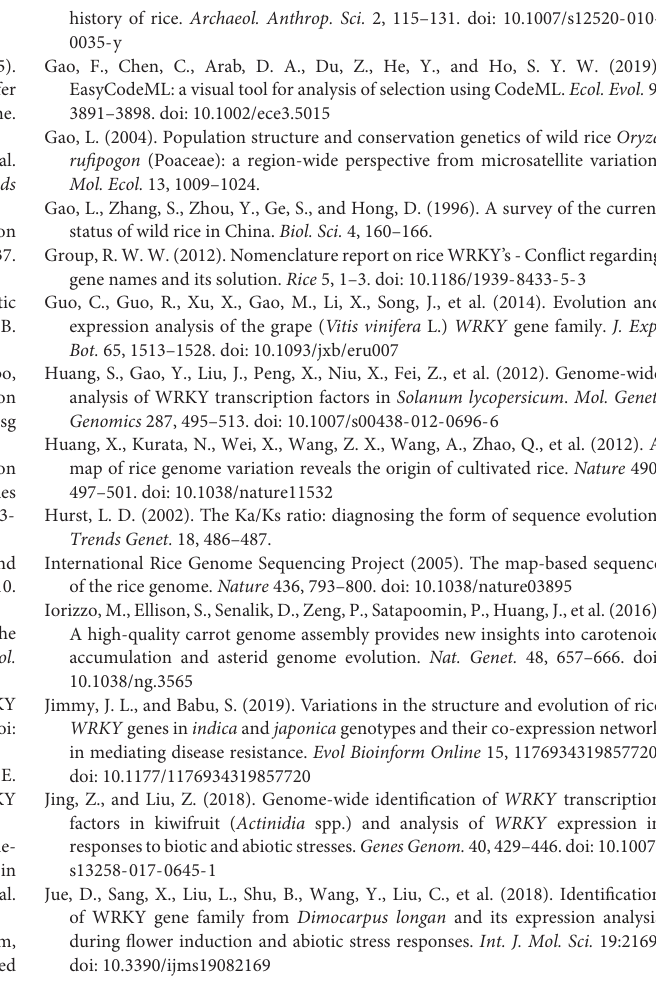
‘N’ and ‘C’ mean the N-terminal and C-terminal WRKY domains of a specific WRKY protein. FIGURE S4 | Phylogenetic analysis of the WRKY genes in Arabidopsis , O. sativa ssp. japonica , O. sativa ssp. indica , O. rufipogon, and O. nivara . The phylogenetic tree was constructed using Neighbor-Joining method based on 531 WRKY domain sequences. Reliability of the predicted tree was tested using bootstrapping with 1,000 replicates. TABLE S1 | Primer pairs of the 10 OrWRKY genes identified in this study. TABLE S2 | OrWRKY genes identified in Oryza rufipogon and their orthologs in Oryza sativa ssp. japonica . TABLE S3 | Ka/Ks calculation and divergence times of the duplicated OrWRKY gene pairs in syntenic blocks. TABLE S4 | Tandem duplicated gene pairs identified in O. rufipogon . TABLE S5 | The detection of positive selection by the likelihood method with branch-site model for OrWRKY genes. TABLE S6 | Orthologous WRKY genes between O. rufipogon and O. sativa ssp. japonica . TABLE S7 | Detection of positive selection by the likelihood method with branch-site model for OrWRKY genes between O. rufipogon and O. sativa